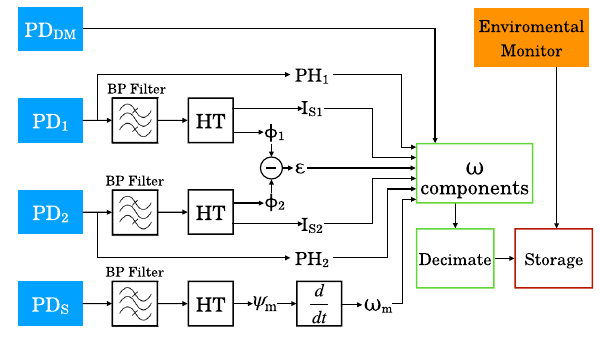
Fig. 2 First analysis level and data storage. Symbols PD ... are used in this figure to denote different photodetectors, BP stands for band-pass, HT for Hilbert transform